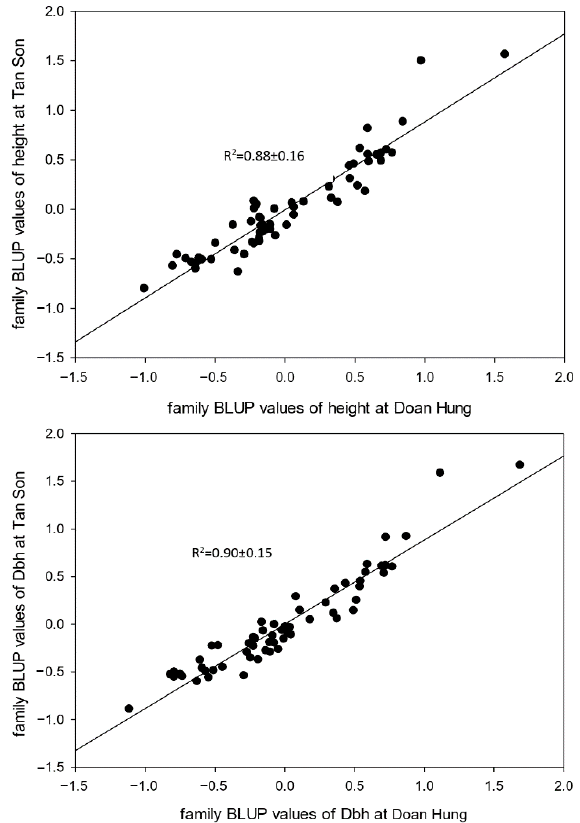
Figure 5. Genetic × Environmental correlation on the growth of 60 D. tonkinensis families between the trials at Tan Son and Doan Hung.